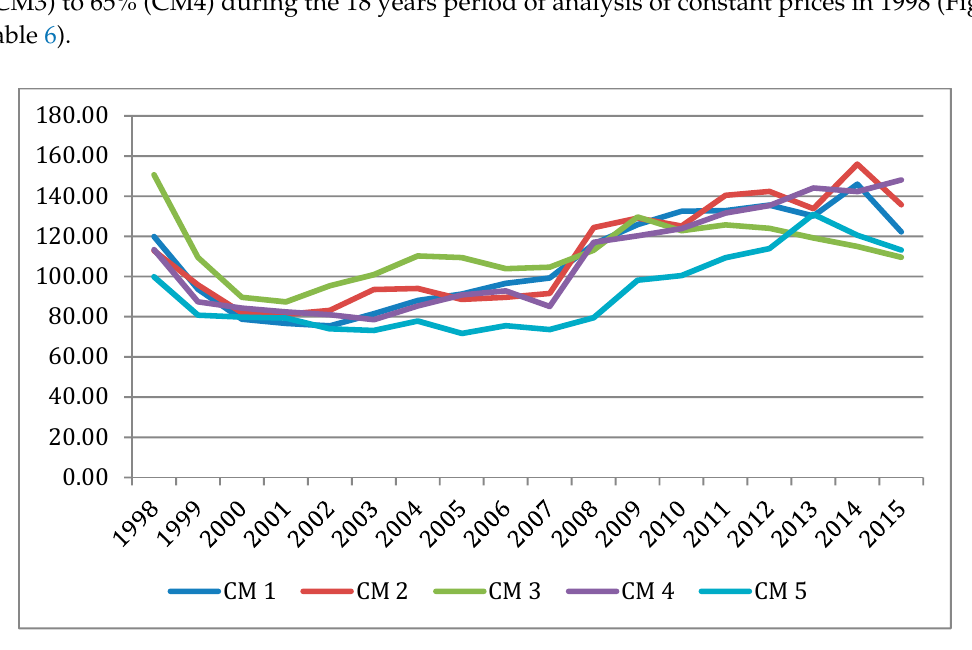
Figure 2. The unit costs in examined coal mines (CM) in constant prices of 1998 (in PLN per Mg).